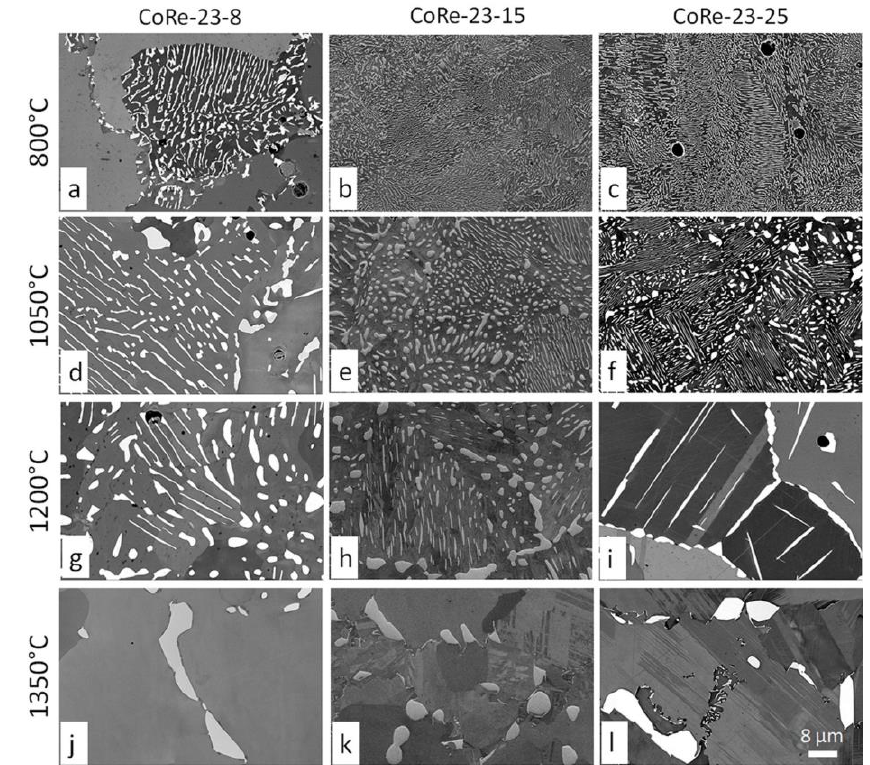
Figure 5. Microstructure of the 23% Cr alloys with varying Ni content (8–25%) after heat treatments at different temperatures: ( a ) 8Ni-800 ◦ C; ( b ) 15Ni-800 ◦ C; ( c ) 25Ni-800 ◦ C; ( d ) 8Ni-1050 ◦ C; at different temperatures: ( a ) 8Ni-800 °C; ( b ) 15Ni-800 °C; ( c ) 25Ni-800 °C; ( d ) 8Ni-1050 °C; ( e ) ( e ) 15Ni-1050 ◦ C; ( f ) 25Ni-1050 ◦ C; ( g ) 8Ni-1200 ◦ C; ( h ) 15Ni-1200 ◦ C; ( i ) 25Ni-1200 ◦ C; ( j ) 8Ni-1350 ◦ C; 15Ni-1050 °C; ( f ) 25Ni-1050°C; ( g ) 8Ni-1200 °C; ( h ) 15Ni-1200 °C; ( i ) 25Ni-1200 °C; ( j ) 8Ni-1350 °C; ( k ) ( k ) 15Ni-1350 ◦ C; ( l ) 25Ni-1350 ◦ C. All heat treatments: duration 100 15Ni-1350 °C; ( l ) 25Ni-1350 °C. All heat treatments: duration 100 h.